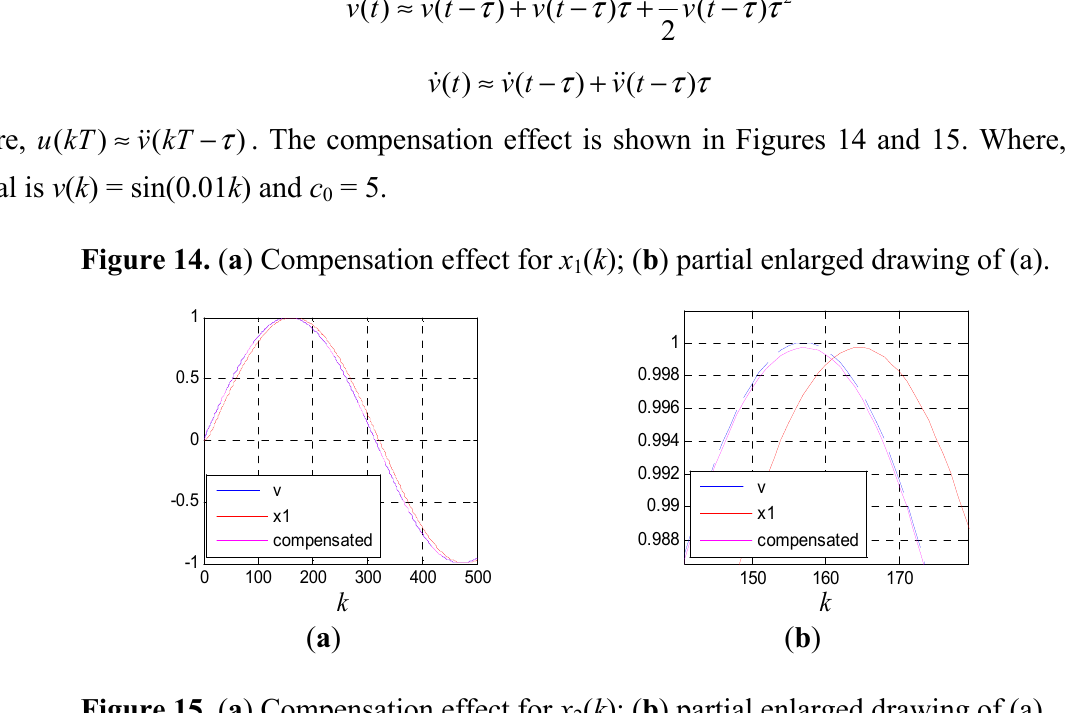
Figure 15. ( a ) Compensation effect for x